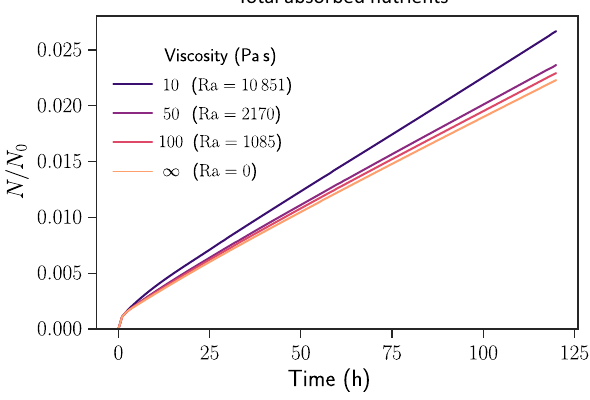
FIG. 18. Total number of nutrient molecules absorbed by the yeast relative to the original number of nutrient molecules in the fluid N=N 0 as the fluid viscosity is varied. The height of the fluid is H ¼ 7 mm and the rest of the simulation parameters are set using the values in Table II. The Rayleigh number Ra ¼ ð H 3 β c 1 g Þ = ð D ν Þ varies from 0 to approximately 10 4 due to the changing viscosity ν , and the mass flux number G ¼ ð Ha Þ = ð ρ 0 β D Þ ≡ H= l is fixed at G ≈ 4 . 4 . Note that the stronger advection of the substrate fluid at lower viscosities leads to an enhanced uptake of nutrient